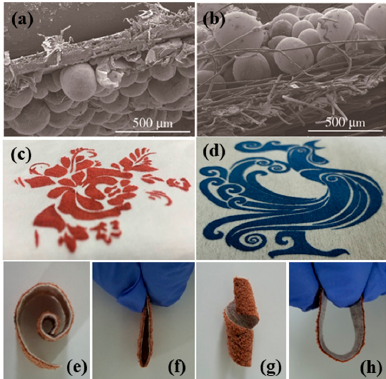
Figure 7. The SEM images of PANI-coated TEMs on different substrate surfaces: ( a ) coated paper, ( b ) non-woven fabric. Screen printing products on different substrates: ( c ) coated paper, ( d ) non-woven fabric. Screen printing products bending performance display: ( e ) curling, ( f ) folding, ( g ) twisting, ( h ) bending.